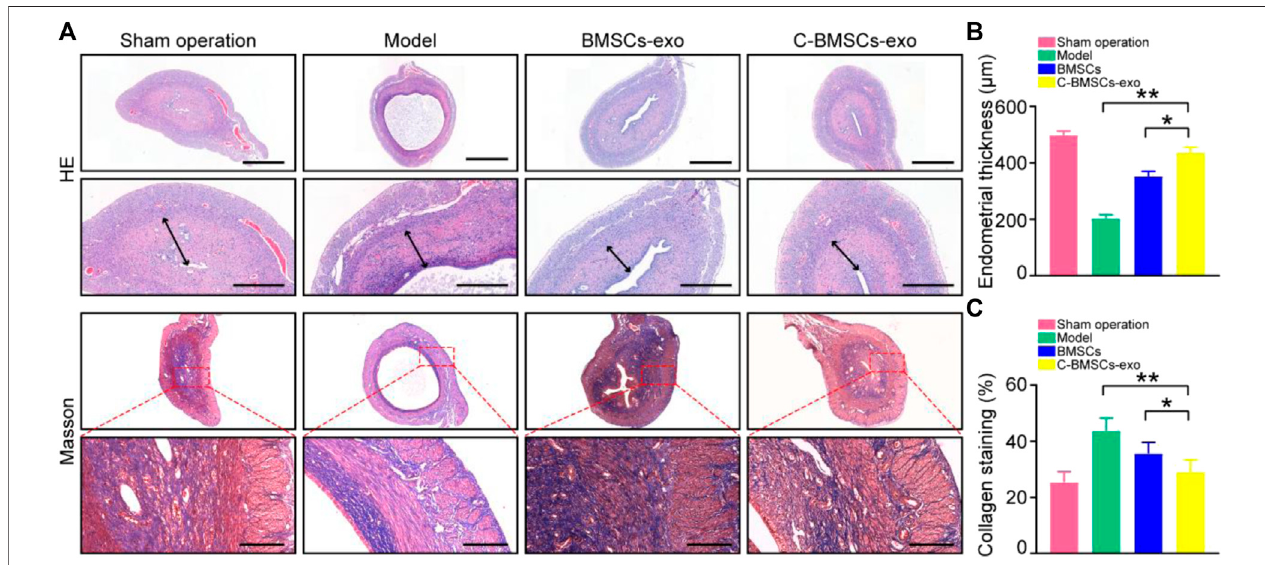
FIGURE 5 | BMSC-exo or C-BMSC-exo treatment promotes endometrial regeneration and reduces endometrial fi brosis. (A) H&E staining was used to assess myometrial regeneration (Scale bars: 1,000 µm, 200 µm), while endometrial fi brosis was assessed via Mason ’ s trichrome staining, with scar formation being shown in blue (Scale bar: 100 μ m). (B) Endometrial thickness in the indicated groups was quanti fi ed ( n = 3 mice per group from three independent experiments). (C) Collagen protein levels in the indicated groups were quanti fi ed ( n = 3 mice per group from three independent experiments). Data are means ± Standard deviation, and samples were assessed in triplicate. * p < 0.05, ** p < 0.01.